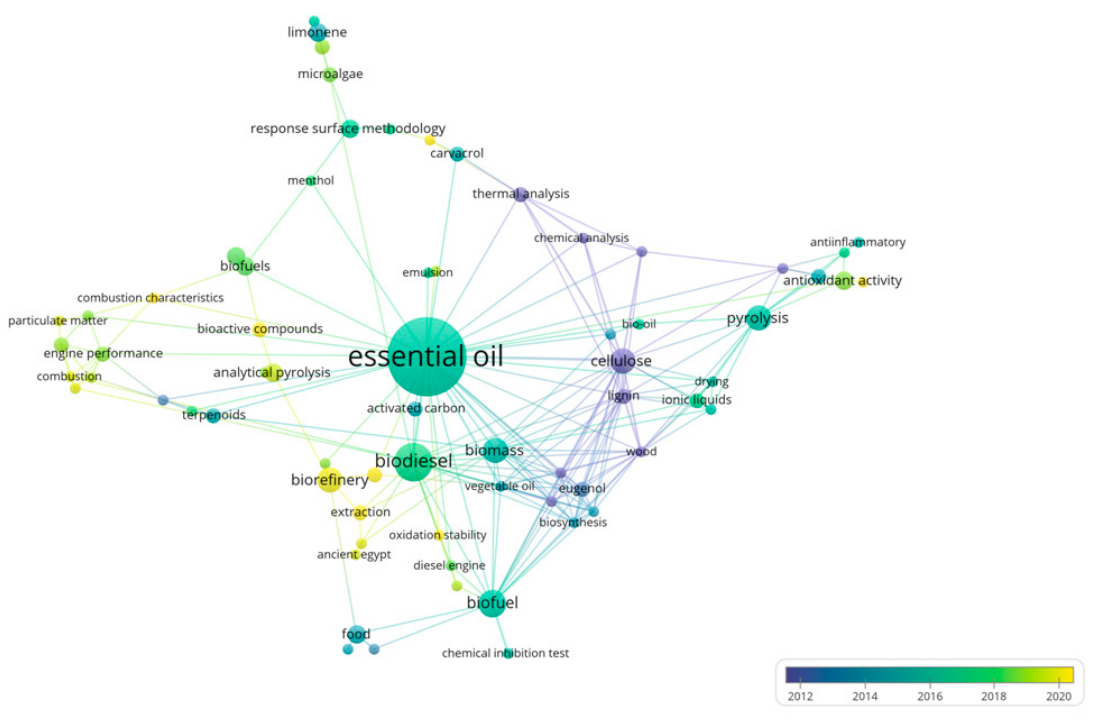
Figure 6. VOSviewer co-occurrence overlay visualization mapping of most frequent keywords (minimum of two occurrences) for Web of Science research on biodiesel production from essential oil.